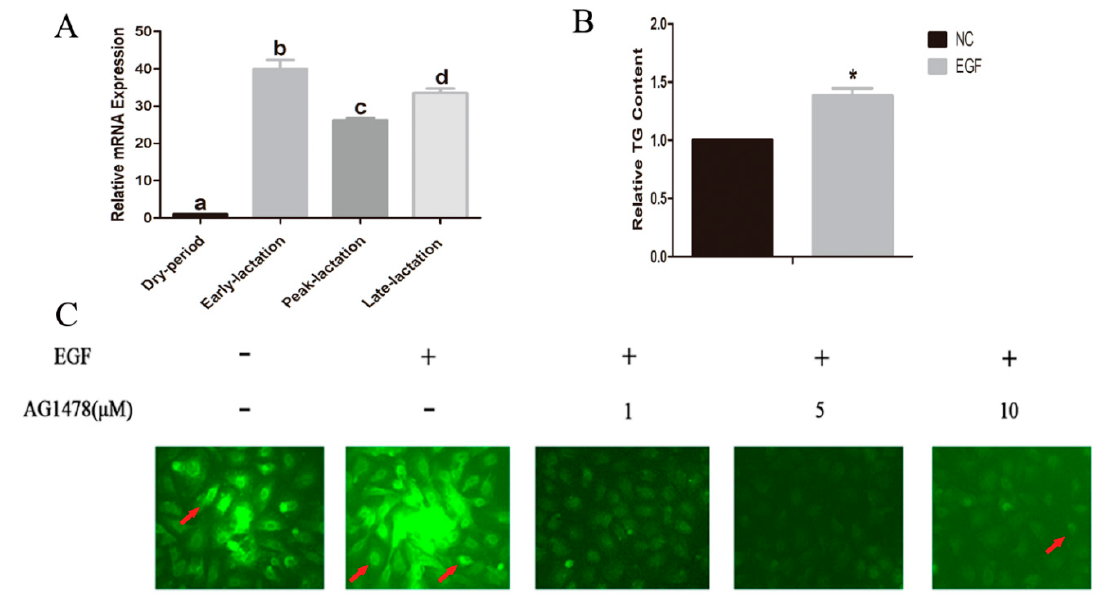
Figure 1. The mRNA expression of EGFR gene in goat mammary gland and effect of EGF on triglyceride (TG) and lipid droplets in goat mammary epithelial cell. ( A ) Goat mammary tissue samples at dry period, early lactation, peak lactation and late lactation were used to investigate the mRNA expression of EGFR gene. It is indicated that the values indicate the means of six individual samples. Different lowercase letters between bars represent p < 0.05. ( B ) GMECs were stimulated with 50 ng/mL EGF for 36 h, to detect TG content in GMECs. Cells cultured in FBS-free medium with no EGF as a negative control. TG was assayed by using a TG assay kit. The values indicate the mean ± SD of three individual samples; “*” means p < 0.05. (C) Lipid droplet formation of GMECs co-treated with AG1478 and EGF was measured by using BODIPY ® 493/503 assay. Scale, 50 microns. Red arrows indicate lipid droplets.